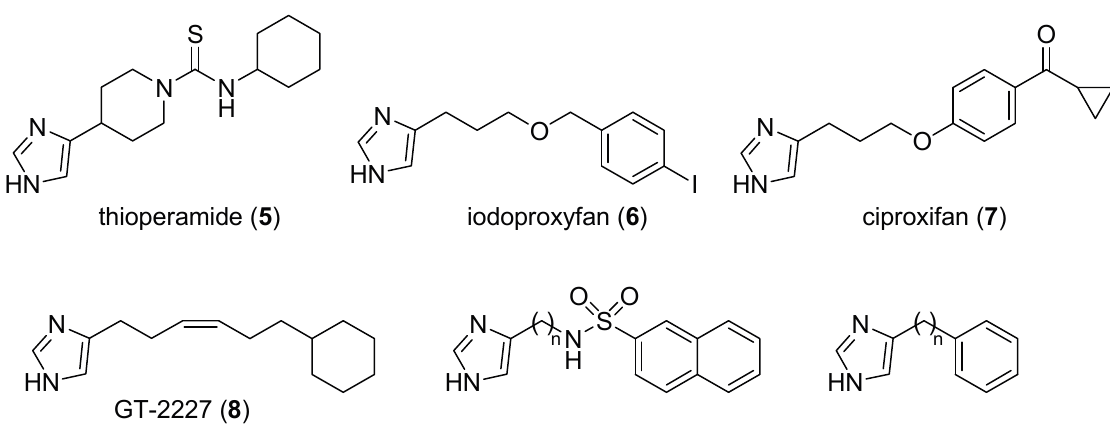
Figure 2. Structures of imidazole-based H 3